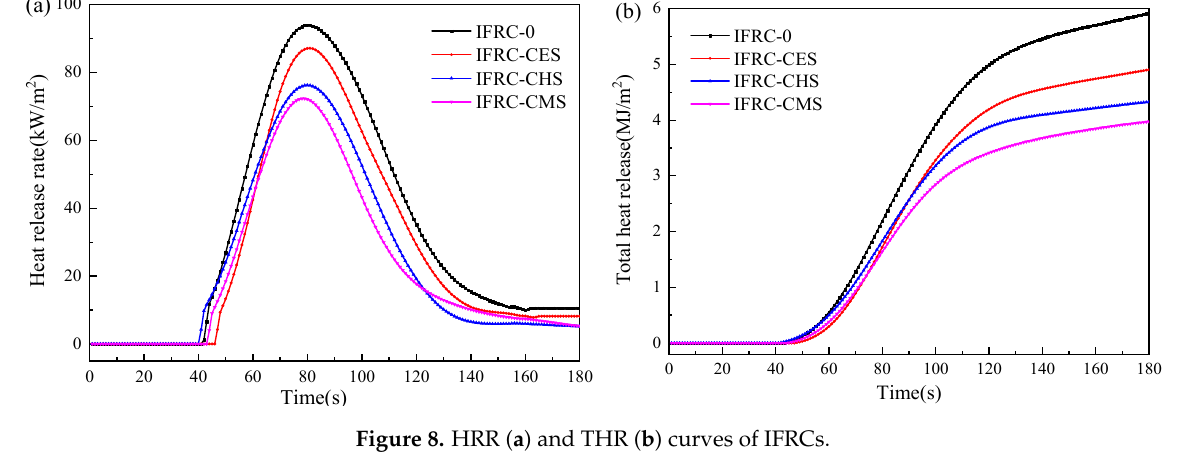
Figure 8. HRR ( a ) and THR ( b ) curves of IFRCs. Table 4. Cone data of the intumescent fire-retardant coatings applied in wood substrate. Samples